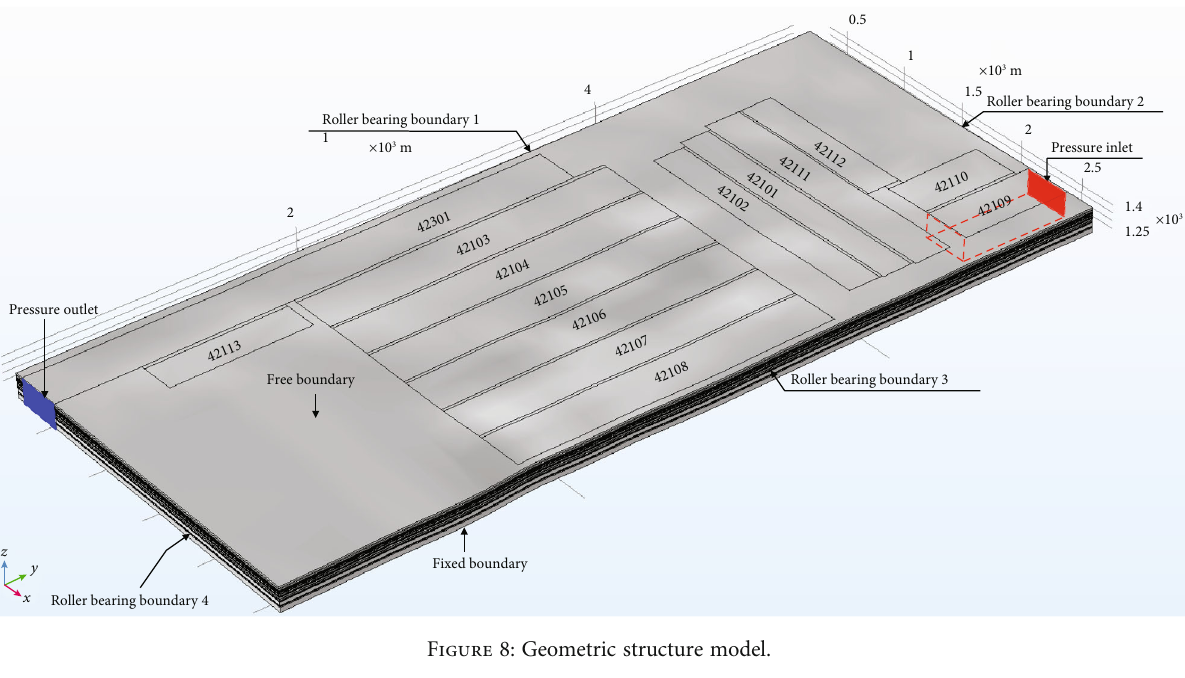
Figure 8: Geometric structure model.